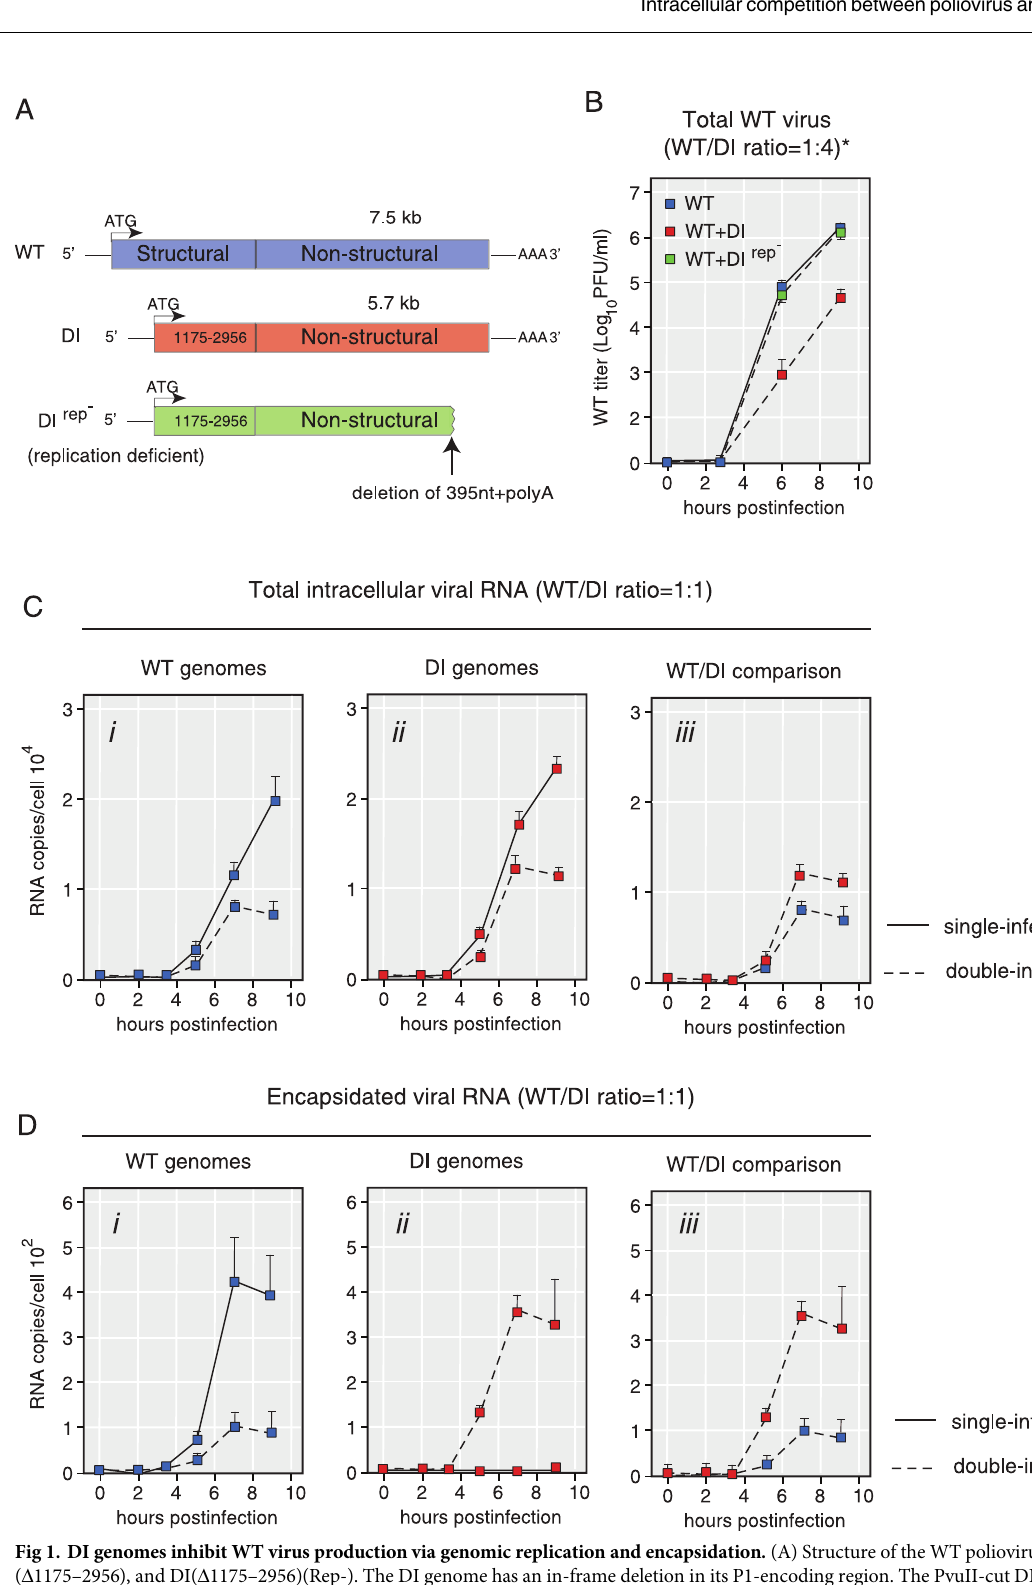
PLOS Pathogens| https://doi.org/10.1371/journal.ppat.1009277 September 27, 2021 4 /